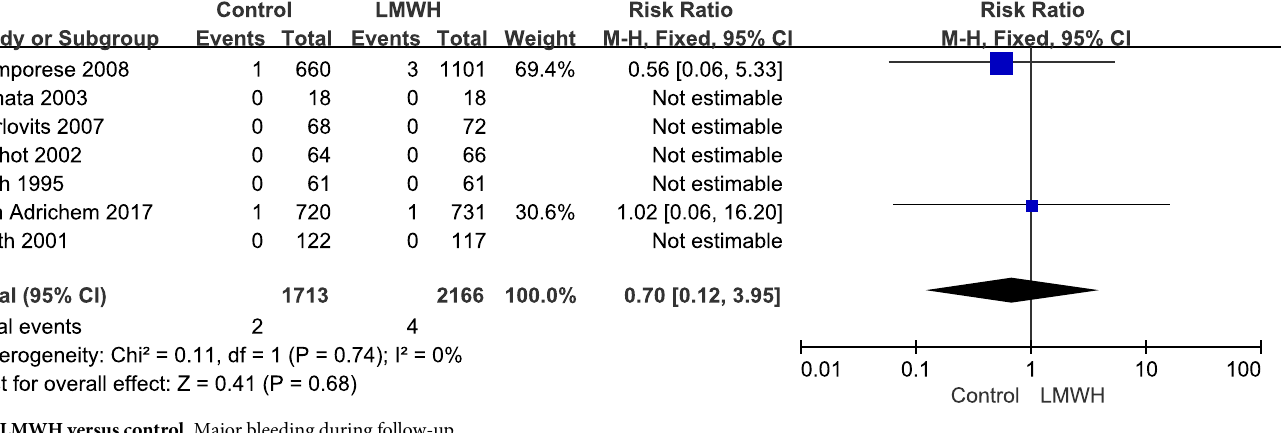
PLOS ONE | https://doi.org/10.1371/journal.pone.0197868 June 21,